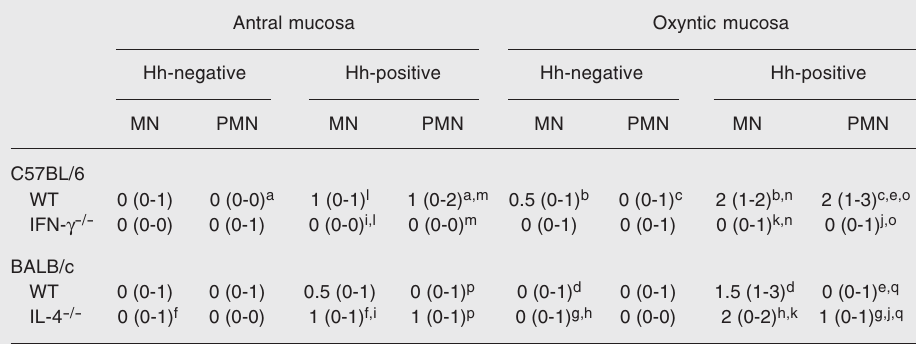
Table 1. Gastric inflammation scores in Helicobacter heilmannii -negative and -positive wild-type and knock- out C57BL/6 and BALB/c